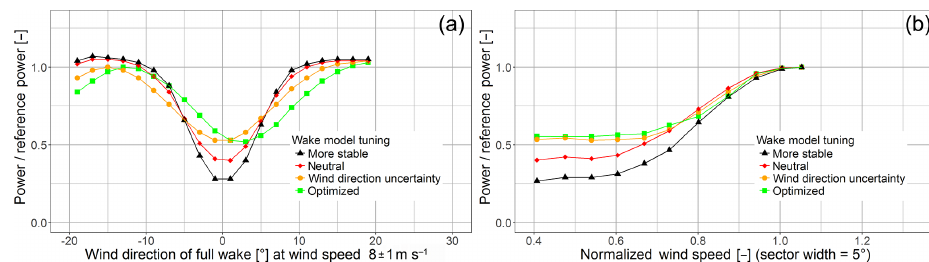
Figure 2. Impact of different key tuning aspects on the wake model results step by step. An increasing atmospheric stability increases the wake deficit (from red markers to black triangles). Wind direction uncertainty flattens the wake deficit (orange points), and a wind direction bias shifts the deficit horizontally (green squares). Panel (a) shows the power of the turbine in the wake divided by the power of a turbine in free-flow conditions as a function of the wind direction. Panel (b) displays the same power ratio as a function of the normalized wind speed (normalized power curve).